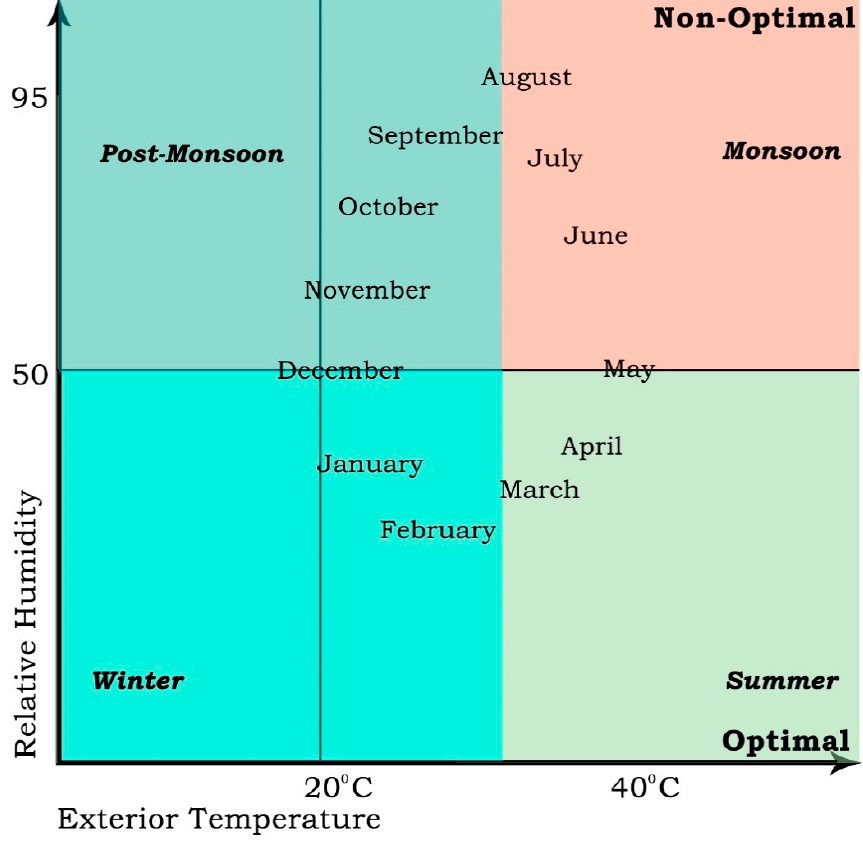
Figure 5. This is a graphical representation of the rubric to evaluate optimal and non-optimal conditions for thermal surveys in